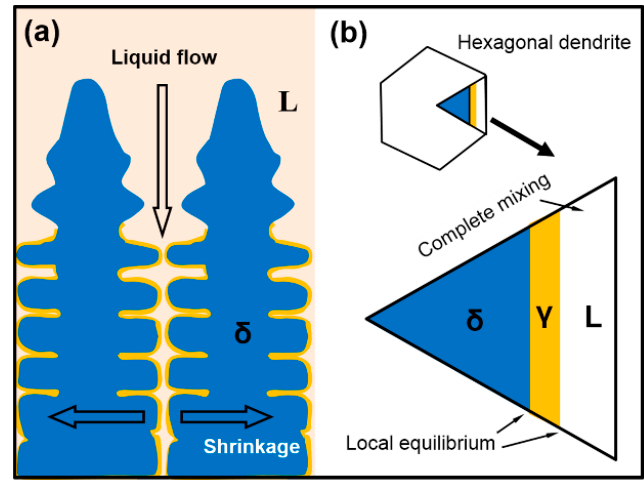
Figure 1. ( a ) Schematic diagram of a solidification interface between solid and liquid; ( b ) calculation model of diffusion ‐ controlled peritectic solidification.